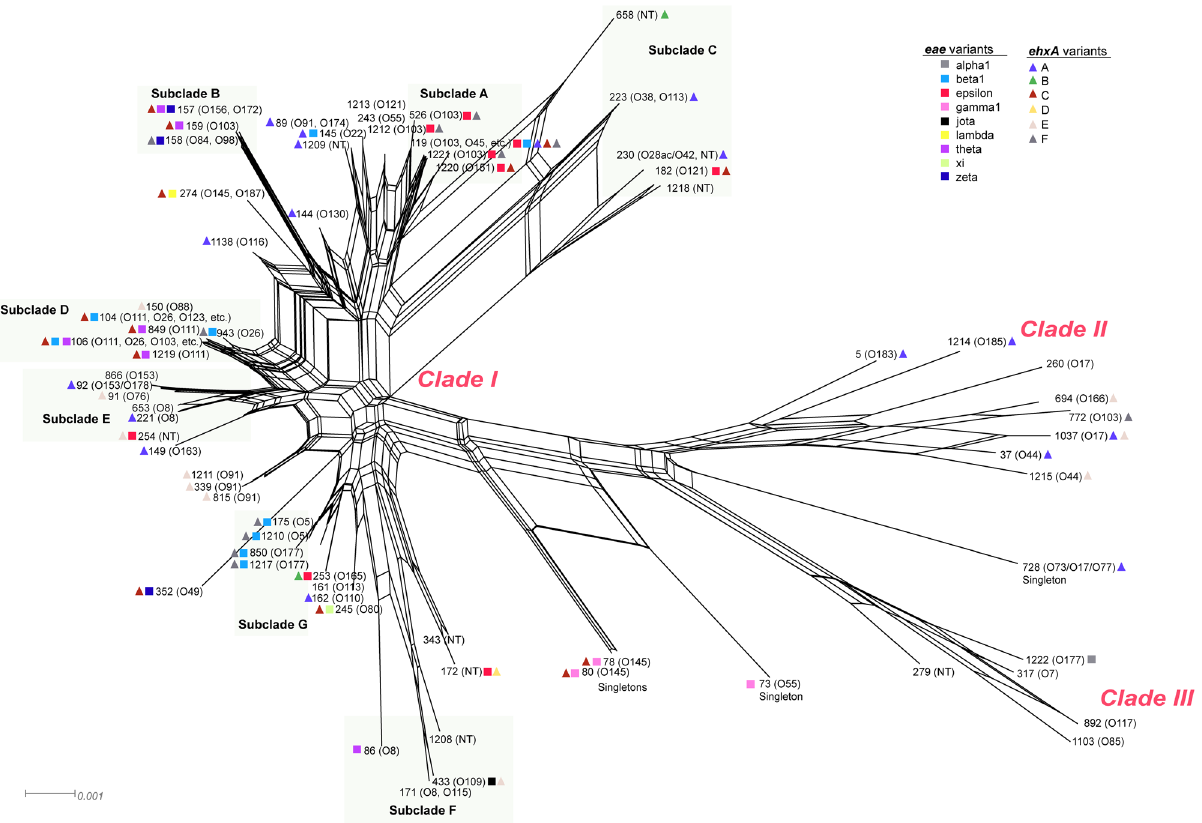
Figure 3. The neighbor-net analysis of 194 parsimonious informative sites among 69 non-O157 Shiga toxin- producing Escherichia coli multilocus sequence types (STs). The phylogenetic network was constructed from untransformed distances using Splitstree4. Recombination is indicated as parallelograms and illustrate multiple paths between most STs. The pairwise homoplasy index (PHI), which was used to test for recombination, was significant (p ≤ 0.00001). The network confirms the tree structure of the neighbor-joining phylogeny and clearly delineates the three clades and singleton STs. The five clade I subclades are shaded with light green rectangles. The STs are indicated at the end of specific branches followed by the serogroups represented. Colored squares represent the intimin ( eae ) allele identified, while the colored triangles are the enterohemolysin ( ehxA ) subtypes.